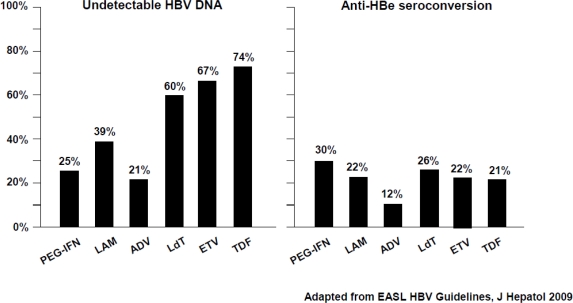
48-week rates of virological response (HBV DNA < 300/400 copies/ml) and HBeAg seroconversion in NUC-naïve HBeAg-positive patients. Collation of currently available data – not from head-to-head studies.